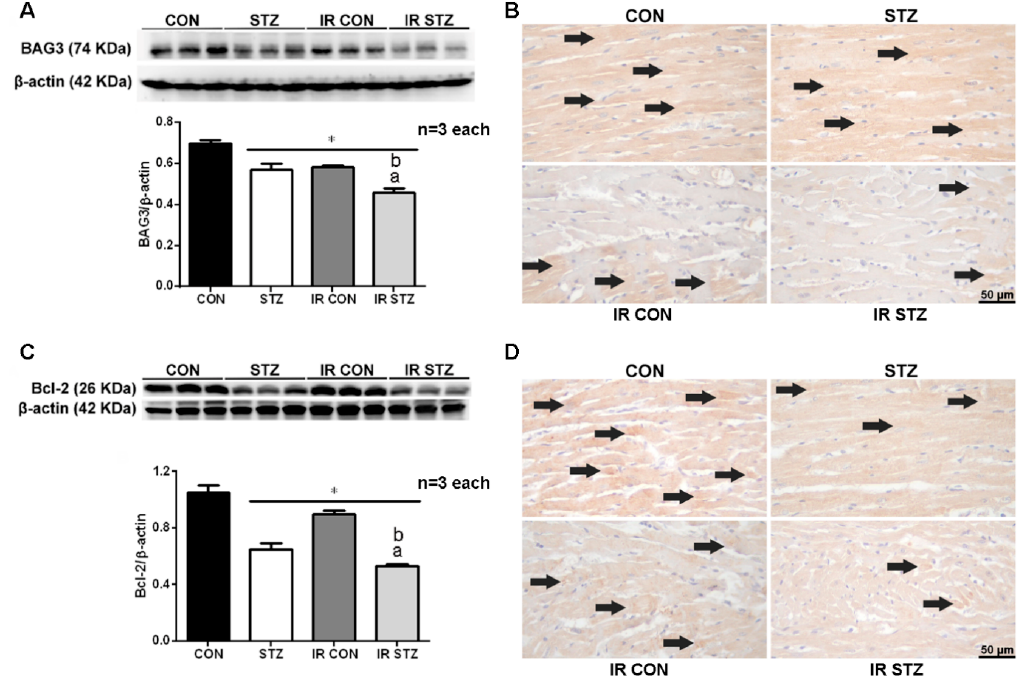
Figure 6. Western blot and immunohistochemistry of BAG3 ( A , B ) and Bcl-2 ( C , D ) in IR myocardium. BAG3 and Bcl-2 expression is significantly decreased in the STZ group than those in the CON group. BAG3 and Bcl-2 expression is also significantly reduced in the IR CON and IR STZ groups as compared with the CON group. IR STZ hearts further depress BAG3 and Bcl-2 expression than IR CON hearts. Data are expressed as mean ± SEM ( n = 3) using the single values. * p < 0.05 vs. CON, a p < 0.05 vs. STZ, b p < 0.05 vs. IR CON.